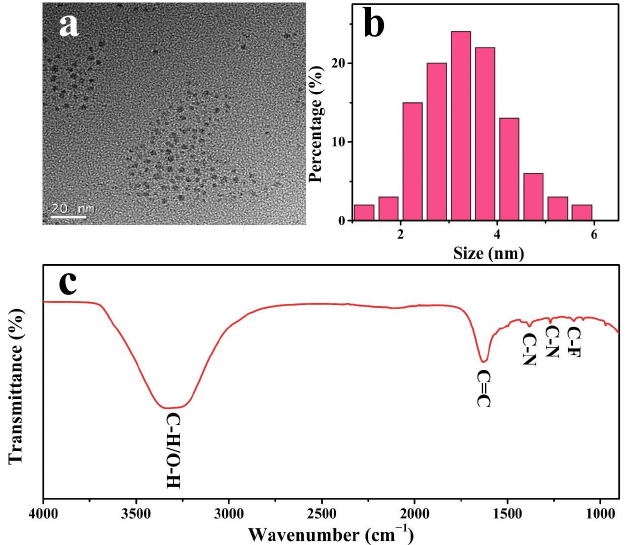
Figure 1. ( a ) TEM image of the N, F-CDs. ( b ) Particle size distribution of the N, F-CDs. ( c ) FT-IR spectrum of the N, F-CDs. To confirm the presence of functional groups and analyze the composition of the N, F-CDs, XPS profiles were obtained. The full XPS profiles of the N, F-CDs (Figure 2a) four